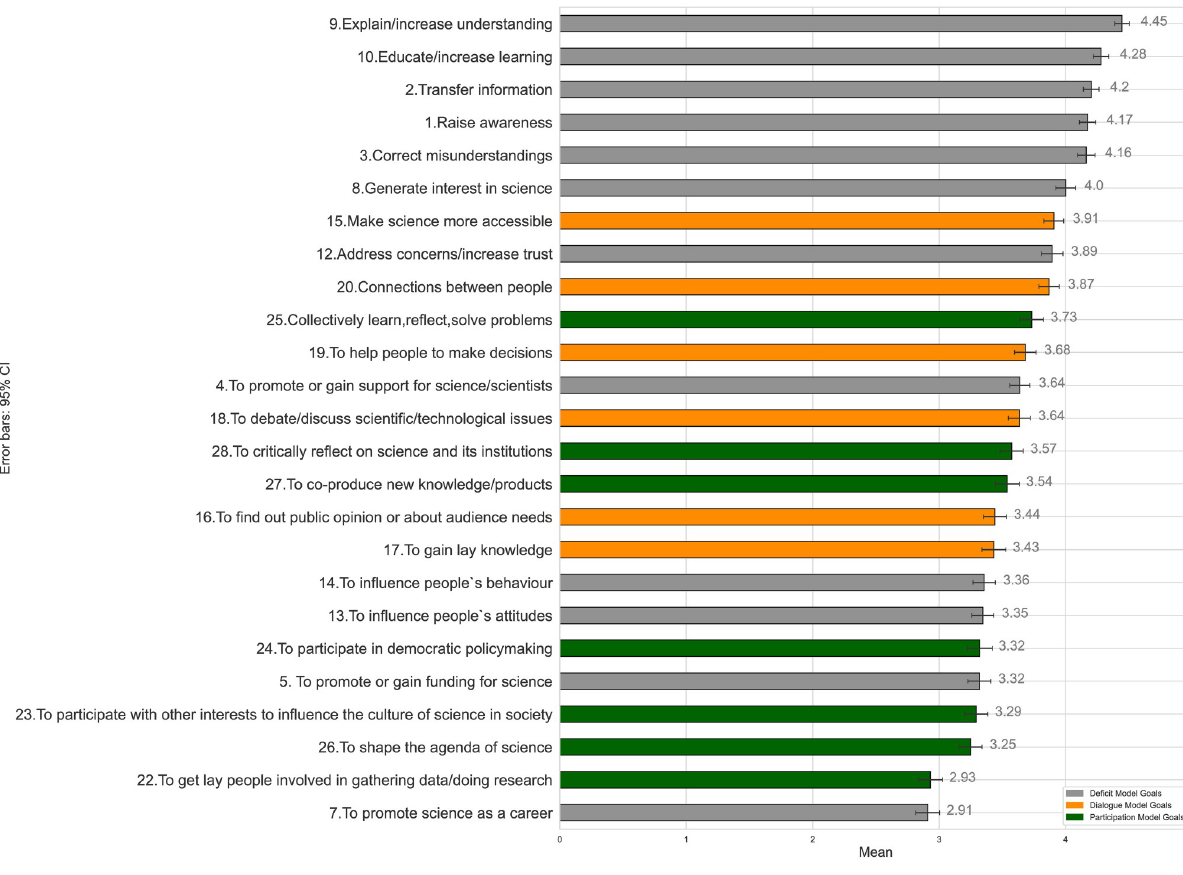
Fig 1. General science communication goals ordered by mean ( N =